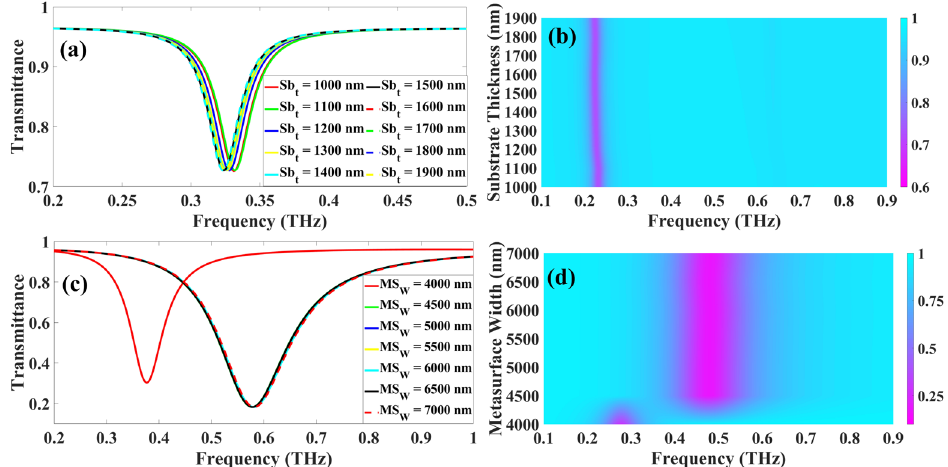
Figure 3. Glass material thickness, Sb t affecting the transmittance plots ( a ) plot exhibiting the uniform and unchanged transmittance as the Sb t enhances from 1000 nm to 1900 nm in a uniform rise of 100 nm, ( b ) color plot exhibiting the left shift in transmittance drops with the increment of Sb t , Metasurface pattern width, MS W affecting the transmittance plots ( c ) plot exhibiting the uniform transmittance response for MS W values of 4000–7000 nm. The only different response is achieved for MS W of 4000 nm, and the comparatively low transmittance drop is observed as well at this point, ( d ) plot exhibiting the uniform transmittance response as the MS W enhances and the only change at 4000 nm is observed, which is clearly visible.